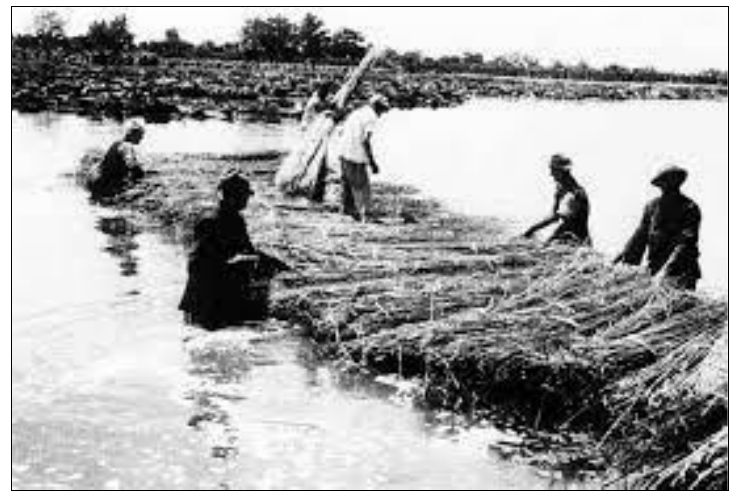
Figure 2. Wetting of hemp in Serbia in the first half of the 20th century. Source: http://www.zdravasrbija.com/lat/Zdrava%20Srbija/2002-Konoplja-nas-podigla,.php (accessed on 10 March 2023).